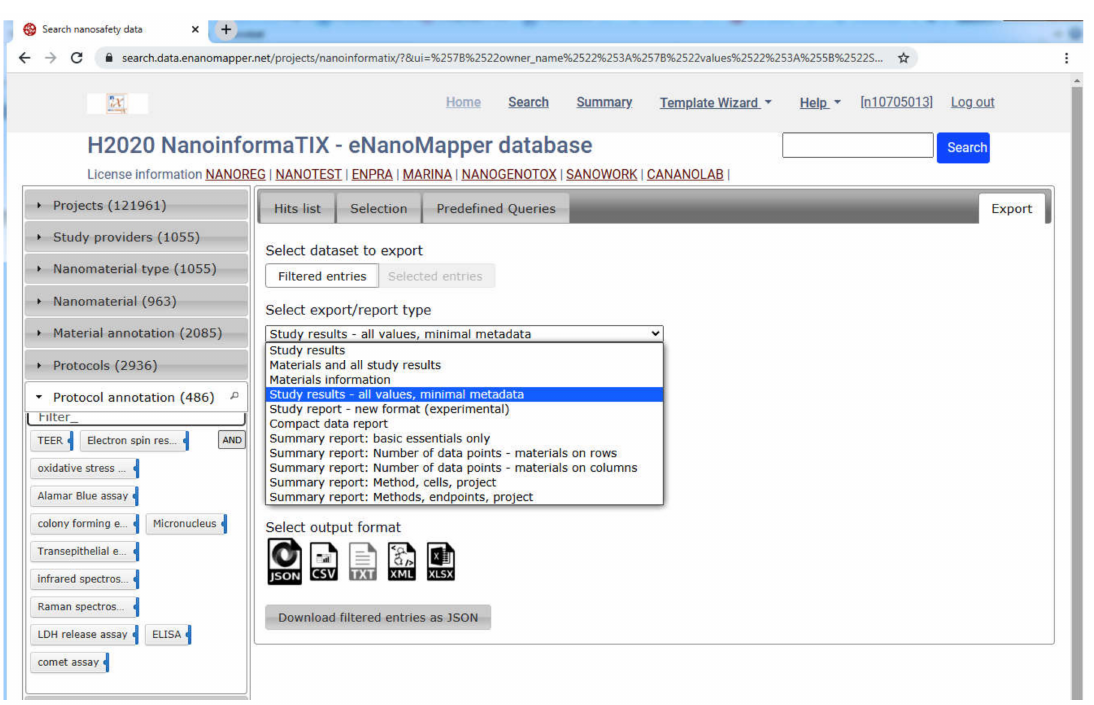
Figure 15. User friendly export facilities at the Nano Safety Data search